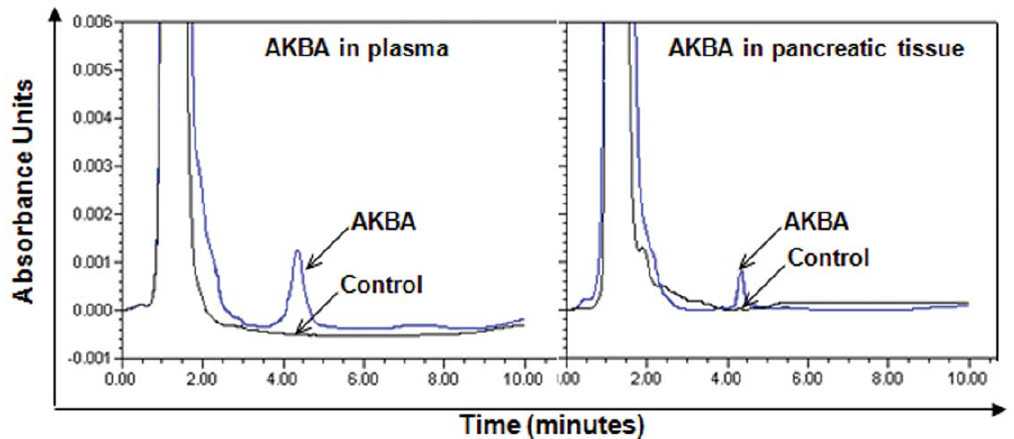
Figure 6. HPLC chromatogram of AKBA in plasma (left) and PaCa tissue (right) in mice.